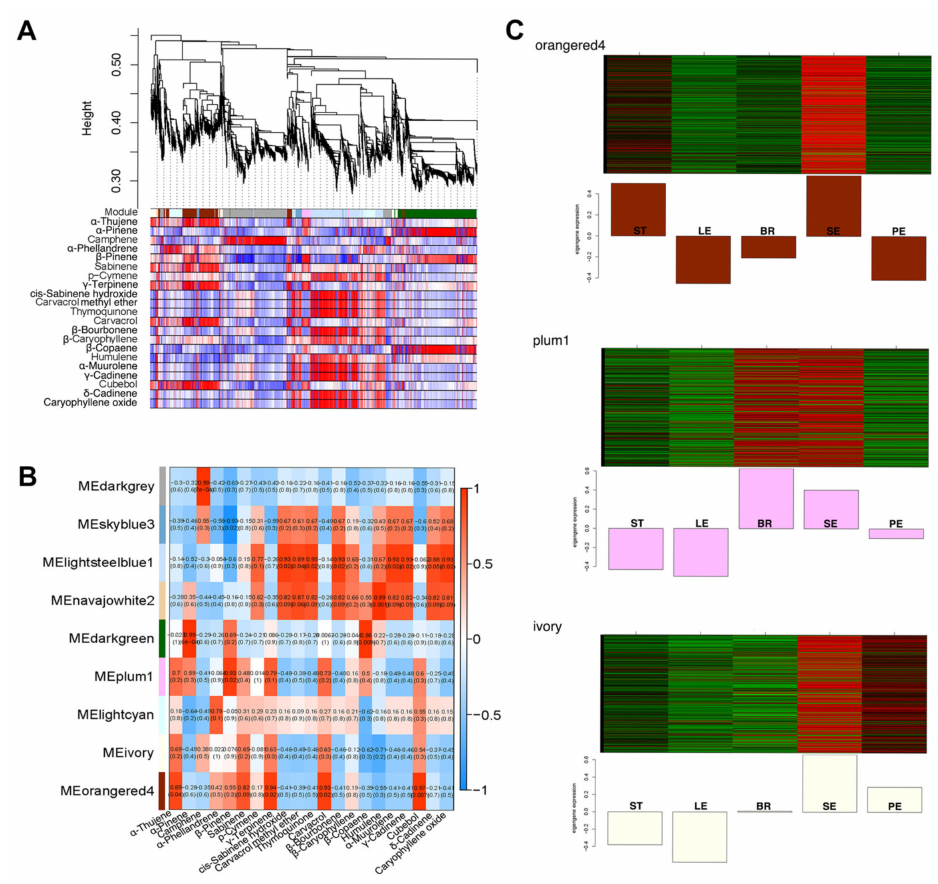
Figure 5. Modular organization analysis of gene expression in different tissues of Origanum vulgare ‘Hot and Spicy’ associated with volatile organic compounds (VOCs). The clustering tree depicts nine modules of co-expressed genes ( A ). Each of the 16,341 DEGs is represented by a leaf on the tree, and the primary branches of the tree represent modules, which are identified in different colors in the lower panel. The correlations between 21 VOCs and 9 modules ( B ). The expression profiles in different tissues of DEGs in orangered4, plum1, and ivory modules (positive with carvacrol content) ( C ). With a highly positive correlation between orangered4, plum1, ivory module genes and carvacrol content, we conducted a GO and KEGG term analysis of these module DEGs (Figure S10). As for GO terms, DEGs enriched in ‘metabolic process’ and ‘cellular process’ showed a high percentage for biological process; DEGs enriched in ‘catalytic activity’